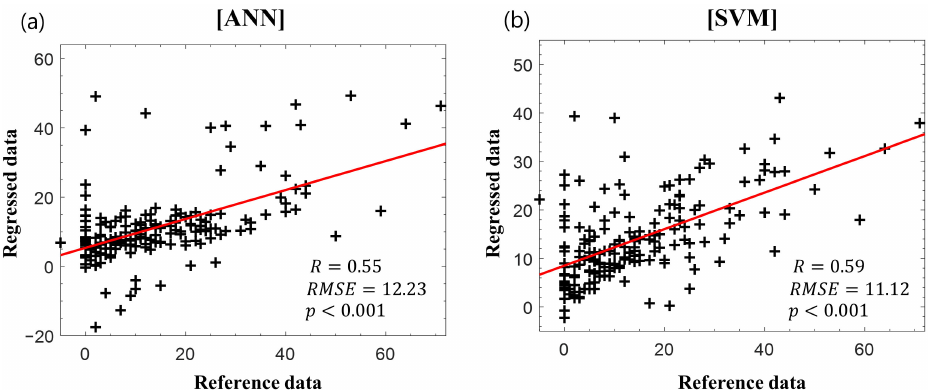
Figure 4. Reference delta K-MBI versus regressed delta K-MBI using ( a ) artificial neural network (ANN) and ( b ) support vector machine (SVM) with the basal K-MBI score and age. The red lines indicate the linear regression